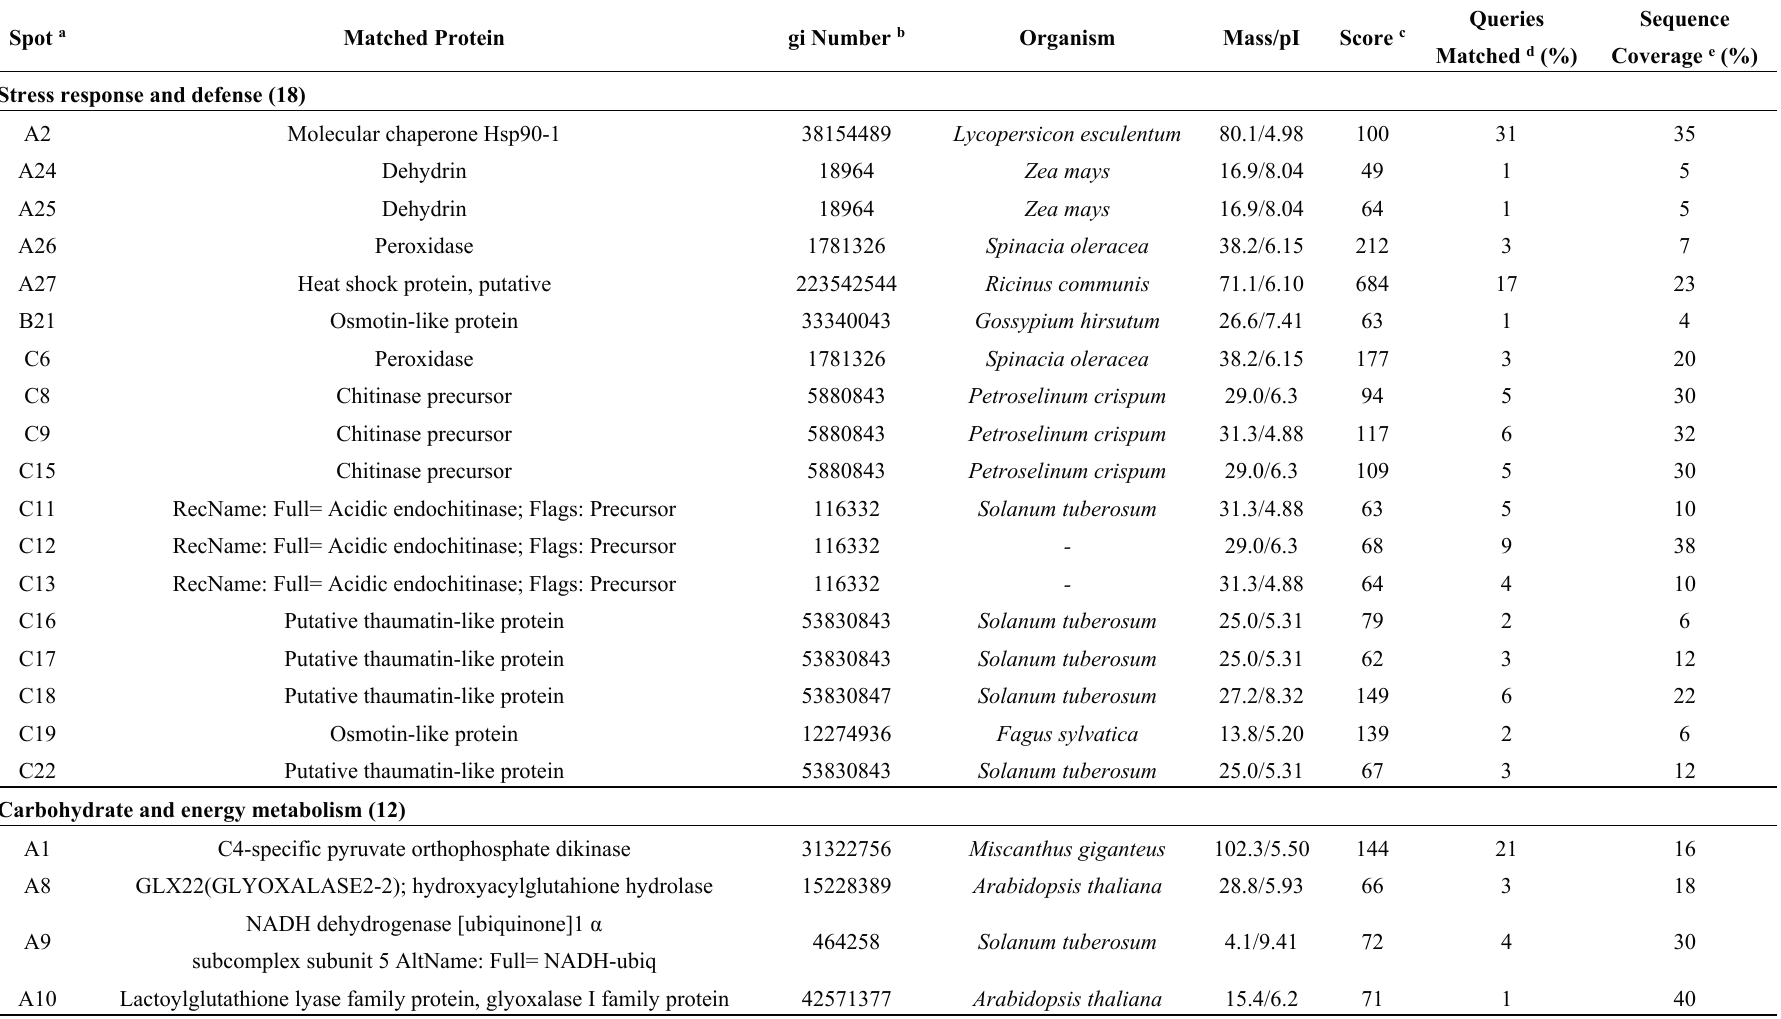
Sequence Queries Coverage e (%) Matched d (%)